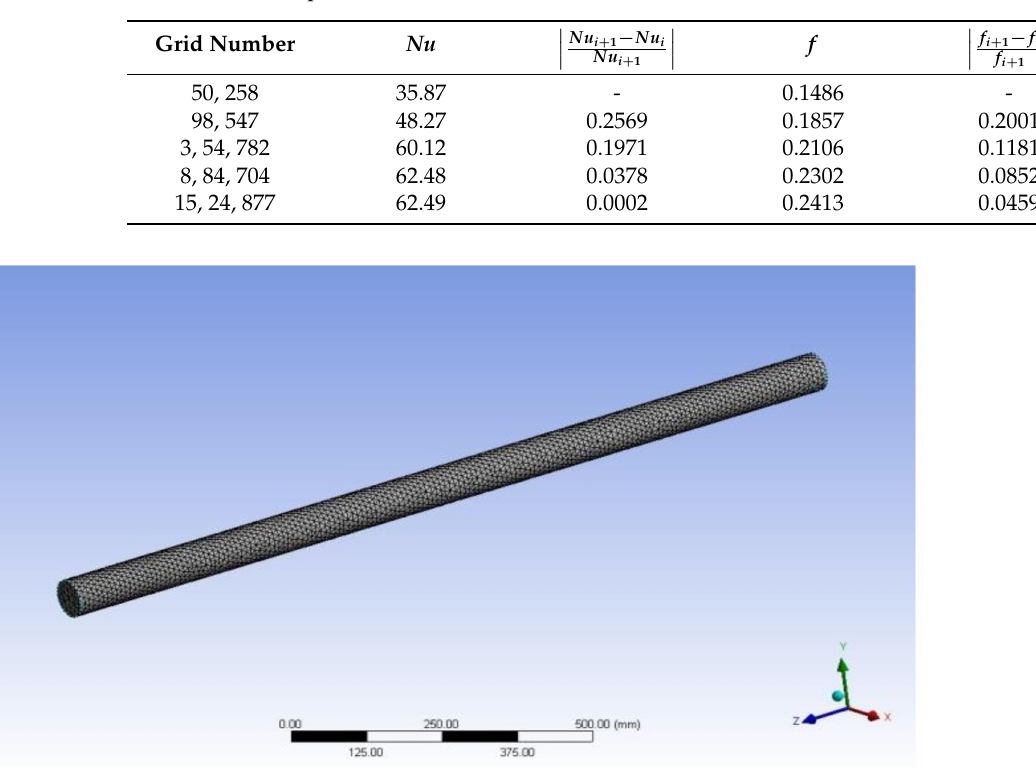
Figure 2. Meshing in Y-shaped insert with triangular